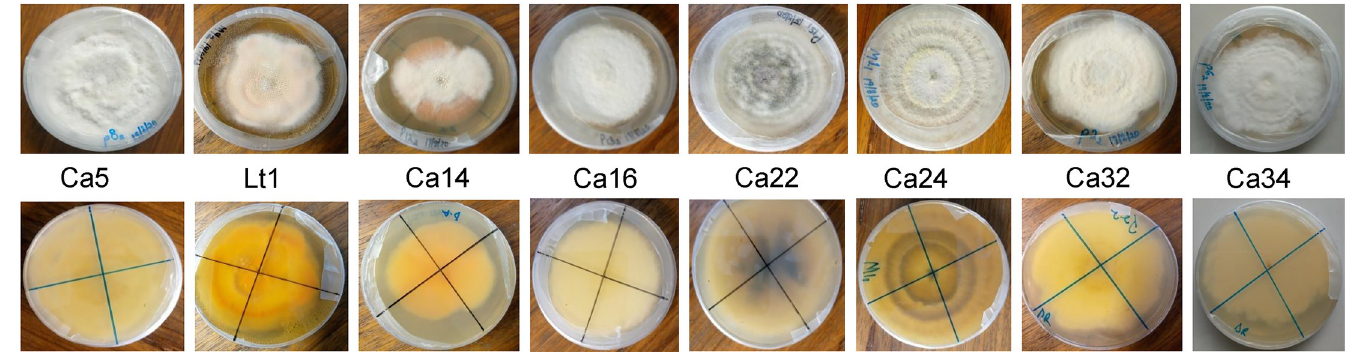
Fig 2. Morphological variability of fungi isolates obtained from the different locations (top row, upper side of the colony; bottom row, reverse side of the colony).